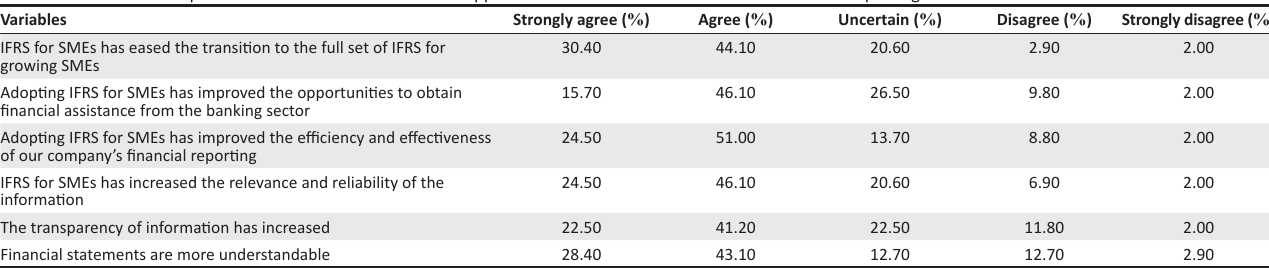
TABLE 3: Extent to which practitioners believed benefits to be applicable to the use of the International Financial Reporting Standards for small and medium-sized entities. Variables Strongly agree ( % )